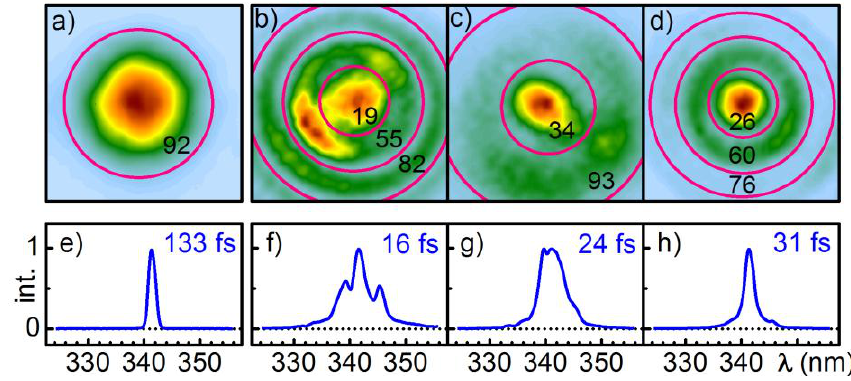
Figure 7. Effect of SPM broadening on the beam profile and spectrum of the third harmonic (342 nm) of the Yb:KYW JenLas laser for various peak powers in a sapphire crystal. The Gaussian shaped (M 2 ~1.05) input profile and spectrum are shown in ( a ) and ( e ). The crystal was placed in the focus ( b , f ), 1 mm ( c , g ) and 2 mm ( d , h ) behind the focus. Pink circles indicate the beam energy for various apertures given in percent of the total energy. Fourier limits are given in